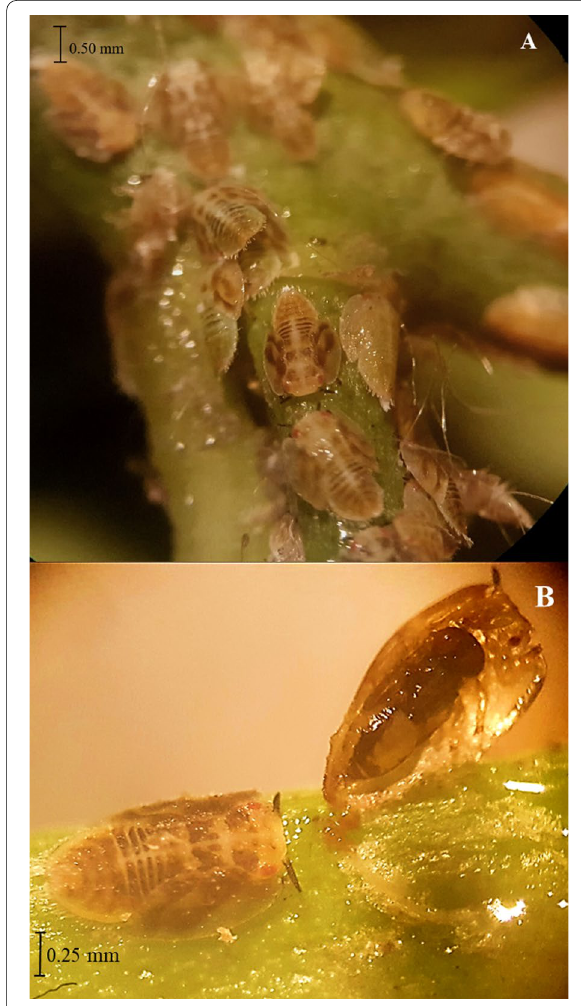
Fig. 5 a Population density of Diaphorina citri nymphs per flush of Citrus x aurantiifolia in the absence of parasitism. Years 2018 and 2019. b Nymphs of Diaphorina citri parasitized by Tamarixia radiata detected on Citrus x aurantiifolia. July